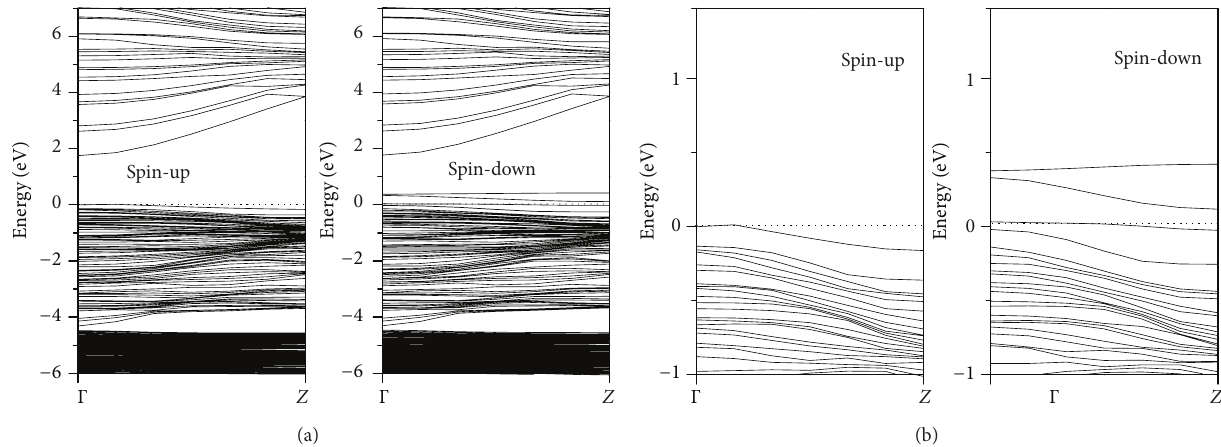
Figure 5: Calculated BS of ZnO nanowire with V Zn defect. The corresponding BS near the Fermi level in Figure 5(a) is plotted in Figure 5(b).